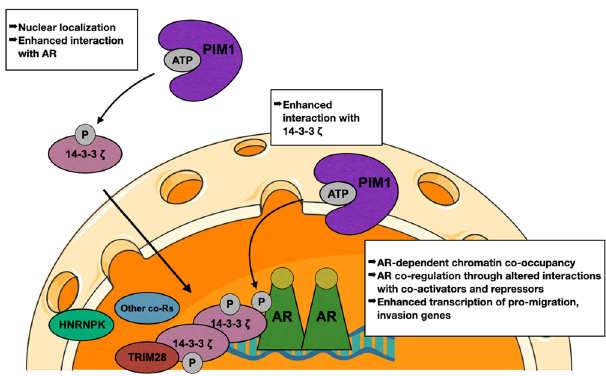
Fig. 9 Model for PIM1-mediated AR co-regulation by 14-3-3 ζ . PIM1 phosphorylation of the AR and 14-3-3 ζ enhances their interaction and shifts their occupancy on chromatin, resulting in 14-3-3 ζ co-regulation of AR, likely by recruiting other AR co-regulators such as hnRNPK and TRIM28. Nucleus image used from